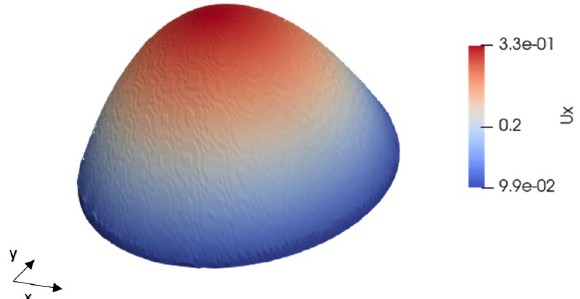
Fig. 21 Elevation of the numerical